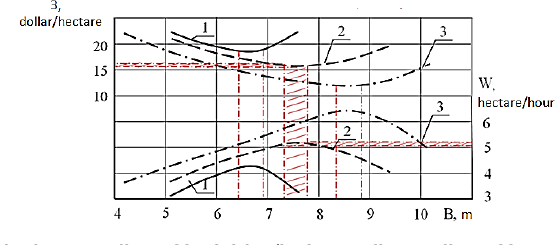
Figure 11. Influence of the working width of the implement on productivity and direct costs (for a tractor with an engine power of 200 kW)